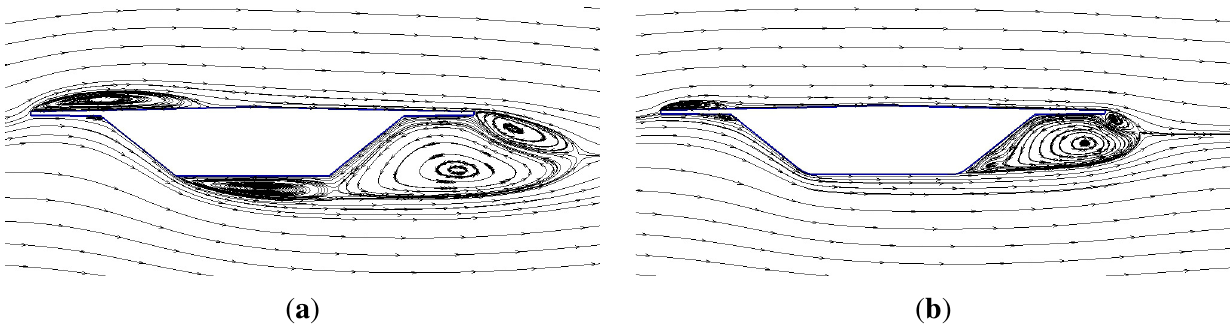
Figure 22. Streamlines of the mean flow field for the bridge section with sharp ( a ) ( R/B = 0) and rounded ( b ) ( R/B = 0.05) lower corners for a null angle of